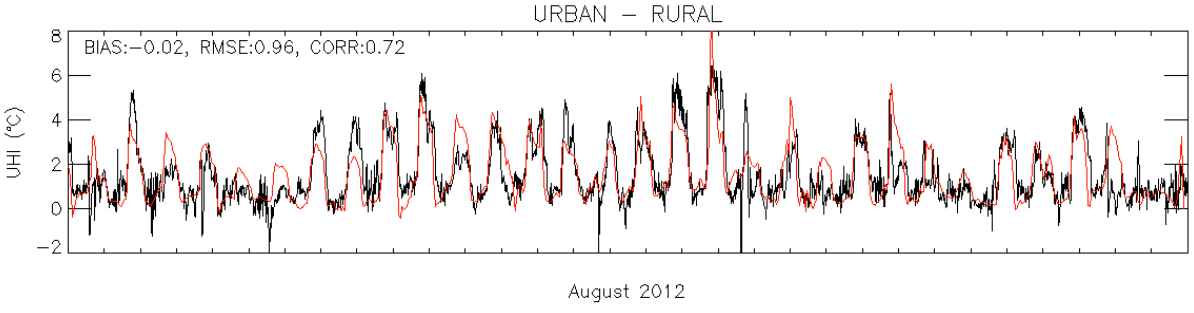
Figure 1. Urban-rural 2-m air temperature difference between the city center and the rural station for the measurements (black) and the UrbClim model (red), for August 2012. Error statistics (model bias, root mean square error and correlation coefficient) are given in the top left of the figure. UHI, urban heat island. The location of both stations is denoted in Figure